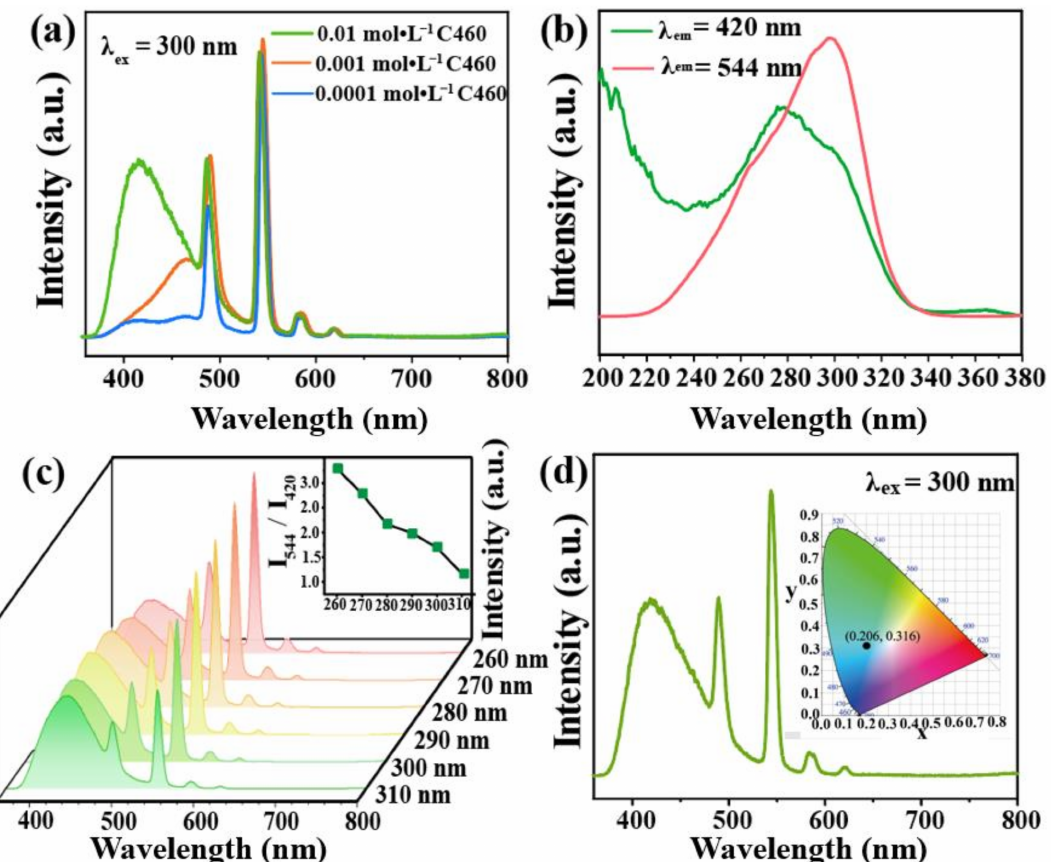
Figure 4. ( a ) Emission spectra of C460@Tb-UiO-66-(COOH) 2 with different initial concentrations of C460; ( b ) Excitation spectra of C460@Tb-UiO-66-(COOH) 2 monitored at 420 nm and 544 nm, respec- tively; ( c ) Emission of C460@Tb-UiO-66-(COOH) 2 with the excitation wavelength from 260–310 nm; ( d ) Room temperature emission spectra of C460@Tb-UiO-66-(COOH) 2 , inset is CIE of chromaticity diagram of C460@Tb-UiO-66-(COOH) 2